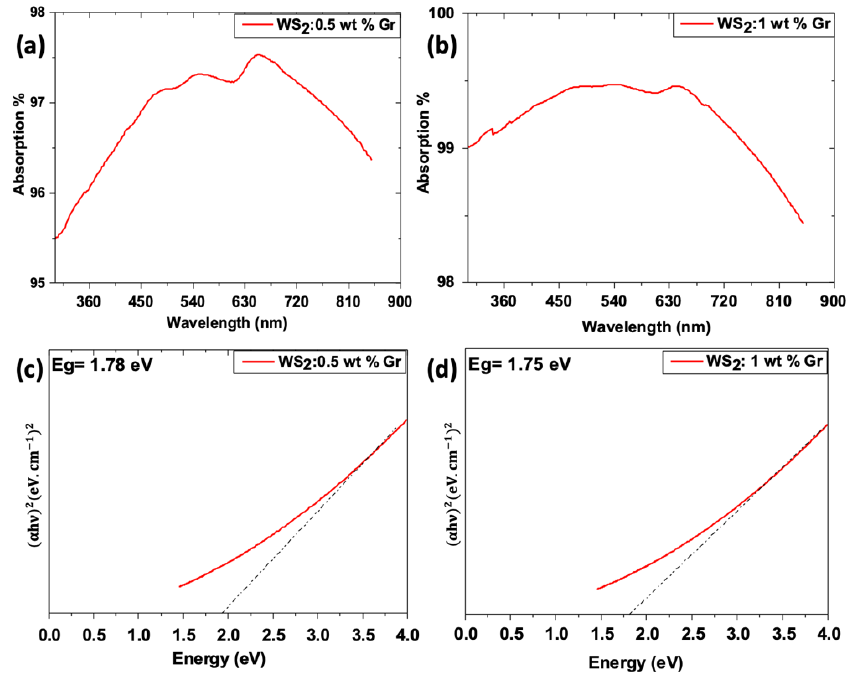
Figure 12. Optical properties of graphene@WS 2 samples: ( a , b ) optical absorption of WS 2 0.5 wt% and 1 wt%, respectively; ( c , d ) corresponding Tauc plots.